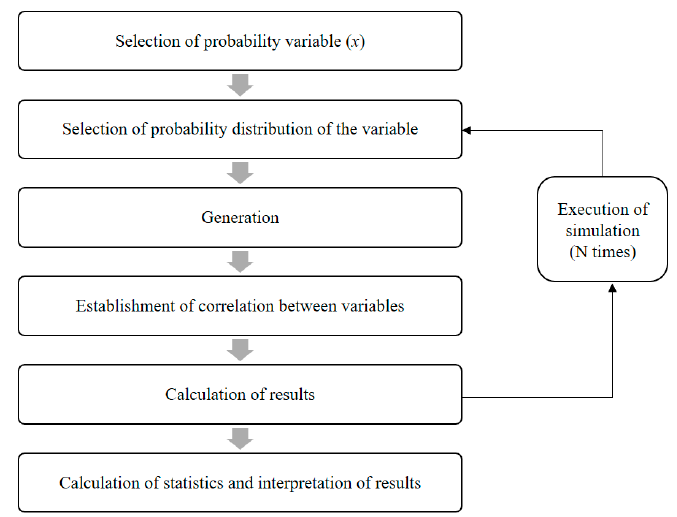
Figure 1. Procedure for the Monte Carlo simulation analysis.